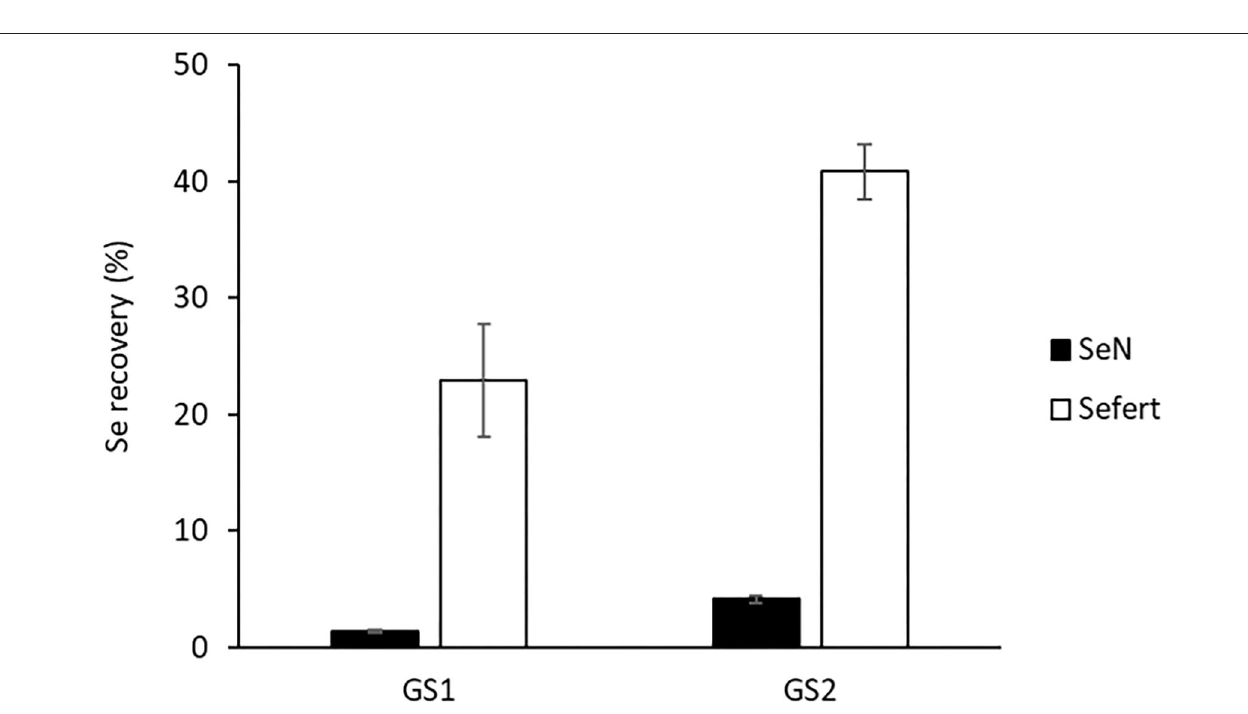
FIGURE 2 | The recovery of native Se (Se N ) and fertiliser-derived Se (Se fert ) in the aboveground biomass of plants (excluding the foliar-treated leaves) harvested at stem elongation (GS1) and the heading stage (GS2). The recovery is the percentages of soil Se or fertiliser-applied Se that was recovered in the aboveground plant parts. Error bars represent SEs ( n =